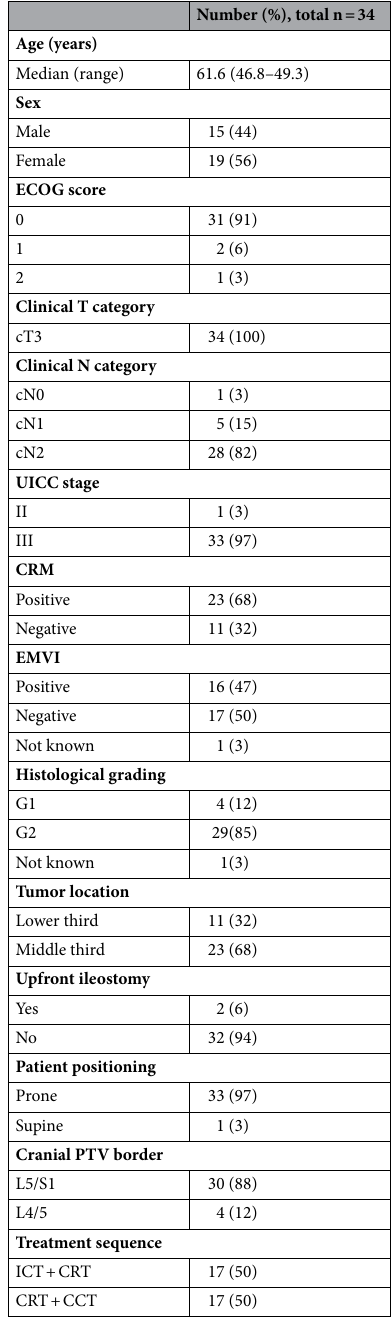
Table 1. Patient, tumor, and treatment characteristics. ECOG = Eastern Cooperative Oncology Group, UICC = Union for International Cancer Control, CRM = circumferential resection margin, EMVI =